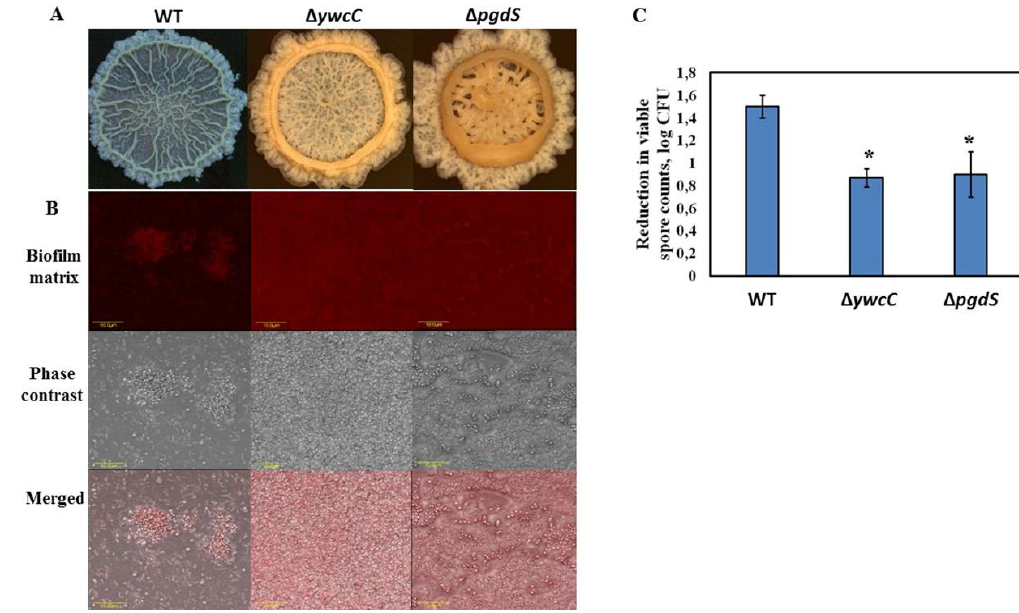
Figure 6. PGA-overproducing derivatives of B. subtilis 3610 exhibit increased resistance to the CIP procedures due to enhanced biofilm formation. ( A ) Colony biofilm formation by the tested Bacillus strains in the biofilm-promoting medium, LBGM. The images were taken using a stereoscopic microscope (Zeiss Stemi 2000-C; Carl Zeiss, Gottingen, Germany). ( B ) Biofilm-derived spores of the PGA-overproducing B. subtilis strains are surrounded by high amounts of extracellular matrix. Protein components of the biofilm matrix were stained red. The samples were analyzed using a confocal laser scanning microscope (CSLM, Olympus, Japan). Scale: 10 µ m. ( C ) The e ff ect of water circulation on the removal of biofilm-derived spores of the PGA-overproducing derivatives of B. subtilis 3610 in the laboratory CIP system. * Statistically significant di ff erence ( p < 0.05) between the reduction in the viable spore counts in a given sample and the reduction in the spore counts for B. subtilis 3610